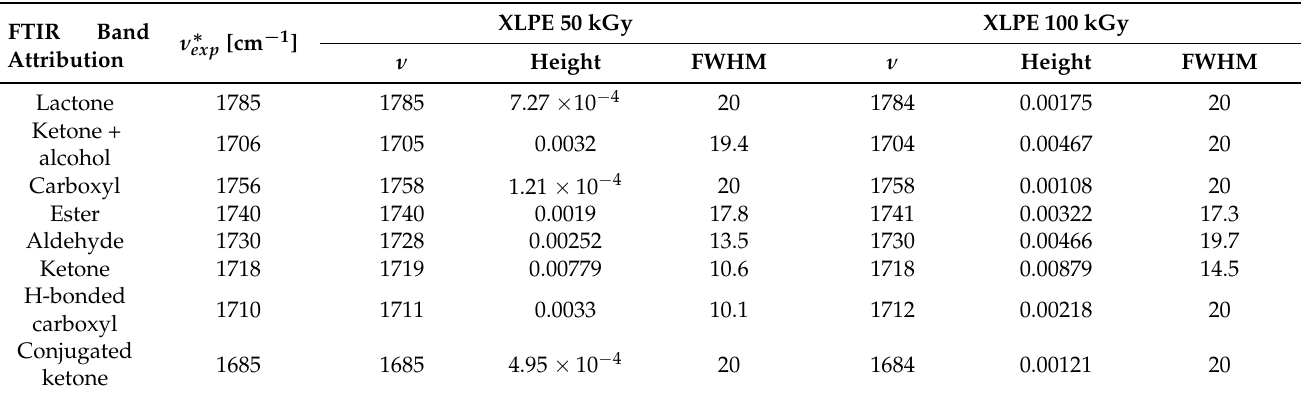
Table 4. Numerical results of the deconvolution for XLPE irradiated at 50 kGy (left) and 100 kGy (right). Constraints on peak positions ν are in Table 2. FWHM of the fitting Gaussians are constrained between 10 and 20 cm − 1